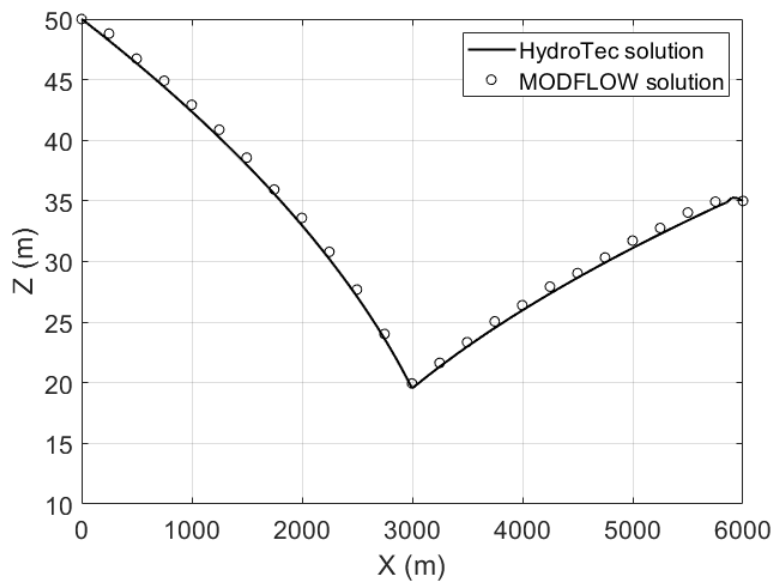
Figure 10. Comparison between the water table simulated with the adaptive MHFEM approximation and the post-processed FDM approximation. There is a good match for the well drawdown. The observed discrepancies far from the well are mainly attributed to post-processing interpolation errors.